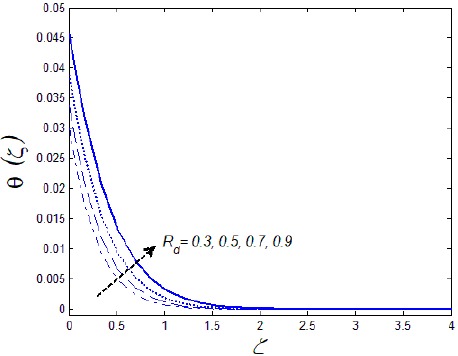
Figure 10. Upshot of R d on temperature field θ ( ζ ) .